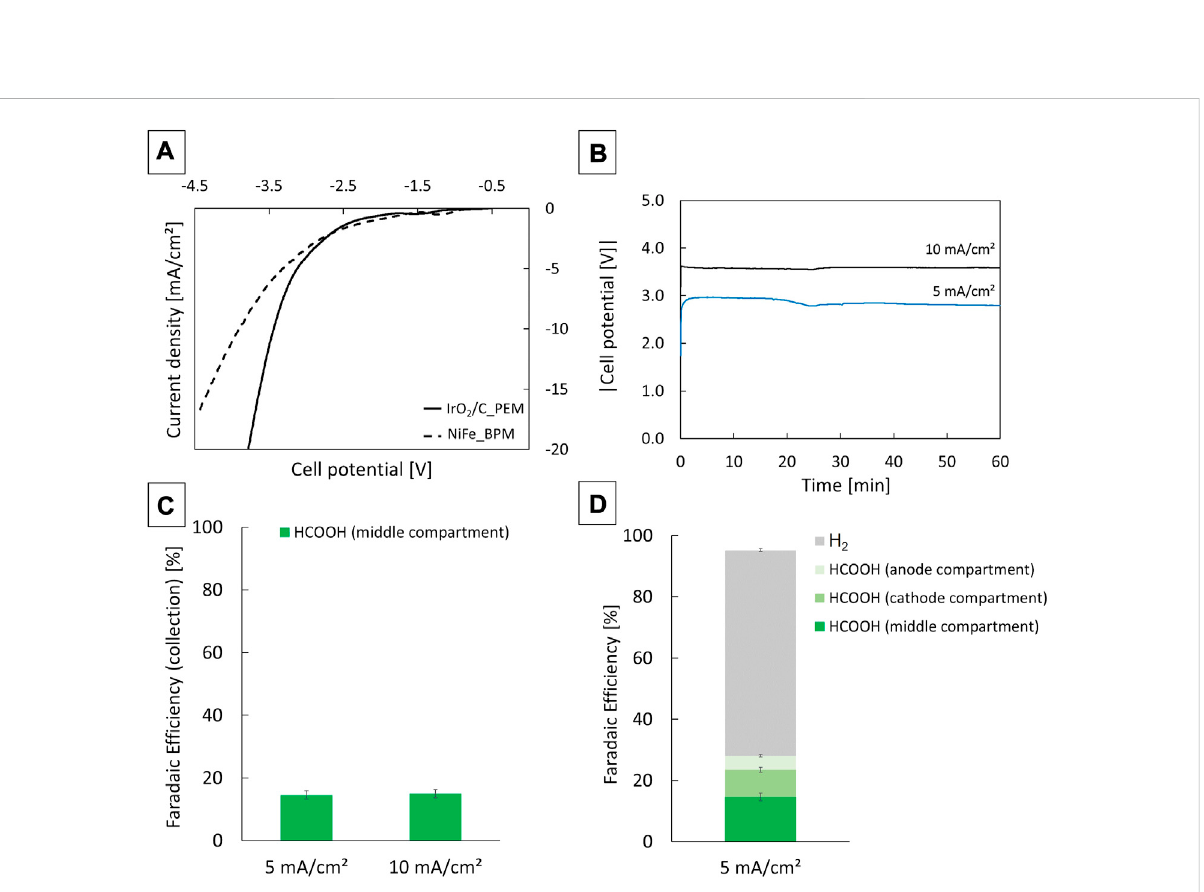
FIGURE 5 Polarization curves of a three compartment formic acid electrolyser with either IrO 2 /C and a PEM or NiFe and a BPM at the anode side. Water was oxidised at the anode, humid CO 2 gas was reduced at the cathode. The scan rate was 5 mV/s (A) . Cell potentials during chronopotentiometry measurements at 5 and 10 mA/cm 2 (B) . Collection faradaic ef fi ciency of formic acid from the middle compartment of the electrolyser (C) and total faradaic ef fi ciency towards formic acid and hydrogen gas (D) . Formic acid was quanti fi ed via ion chromatography by sampling at the end of a 60 min measurement, hydrogen was quanti fi ed via gas chromatography. The error bars correspond to the standard deviation on the ion- and gas chromatography